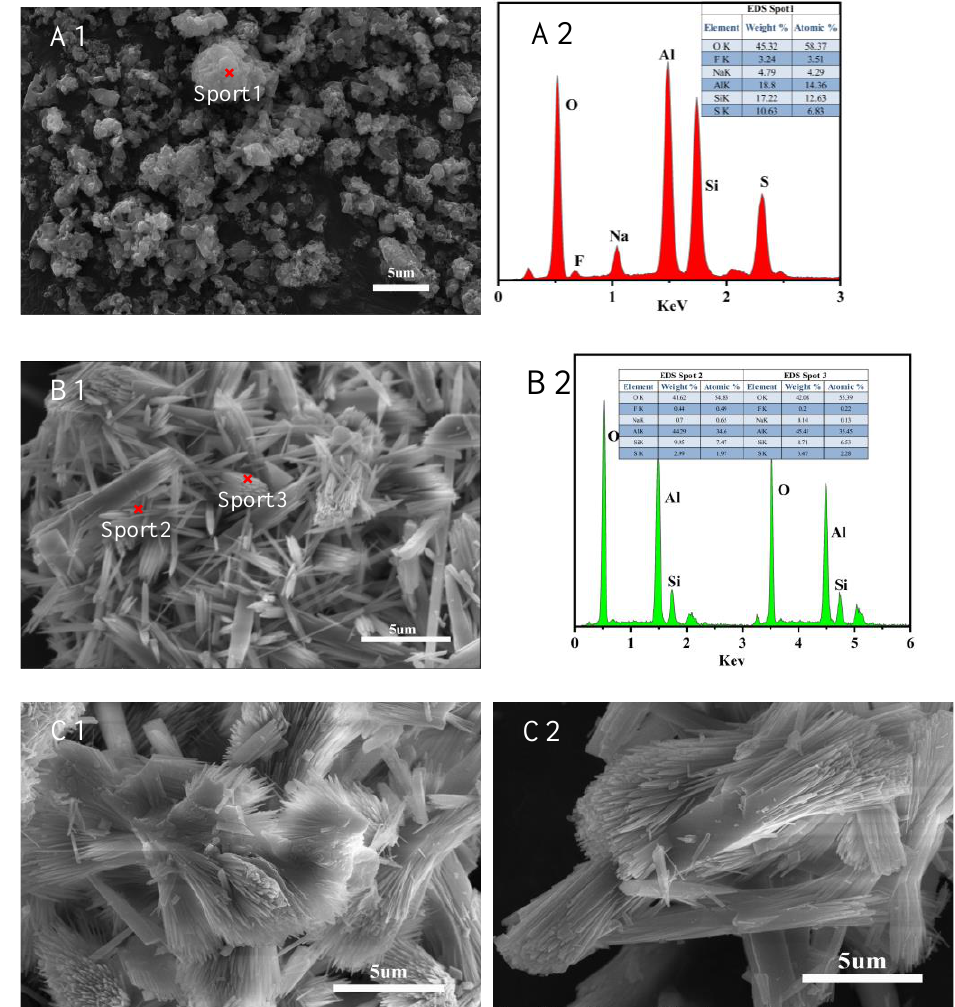
Figure 8. SEM images of mullite whiskers sintered at 700–750 °C. ( A1 ) 700 °C; ( A2 ) the EDS elemental analysis pattern of the corresponding point of A1 ; ( B1 ) 720 °C; ( B2 ) the EDS elemental analysis pattern of the corresponding point of B1 ; ( C1 , C2 ) 750 °C.